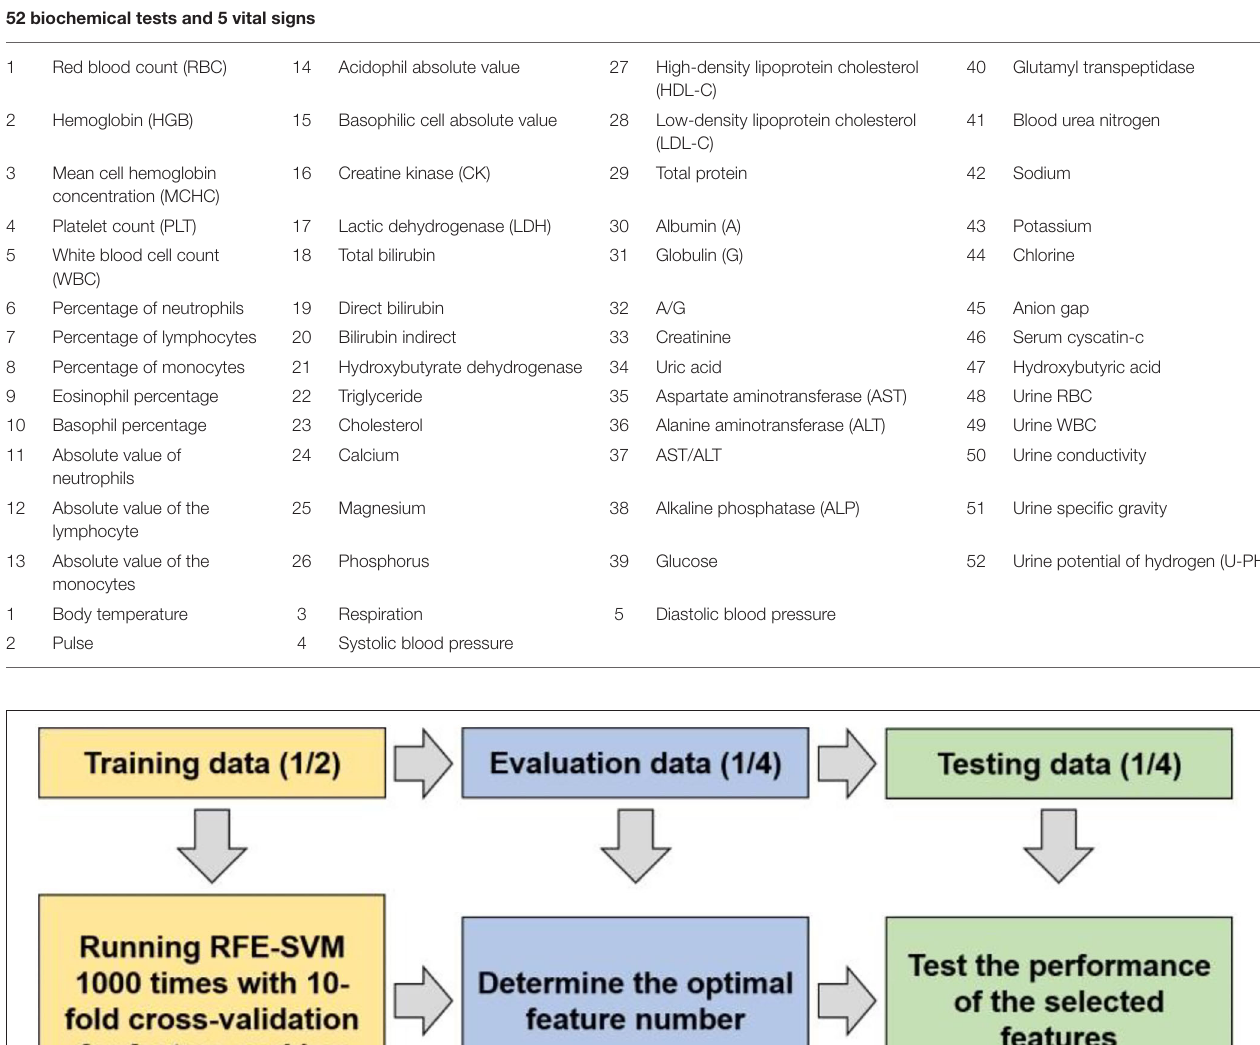
TABLE 1 | The 52 biochemical tests and 5 vital signs. 52 biochemical tests and 5 vital signs